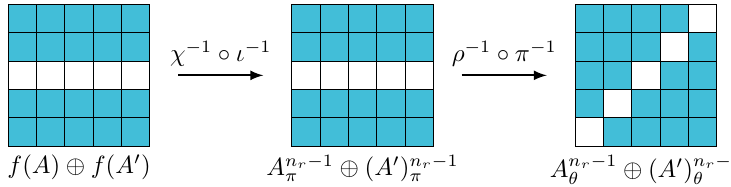
Figure 3: Illustration of Proposition 1 on one slice when the outer state is one